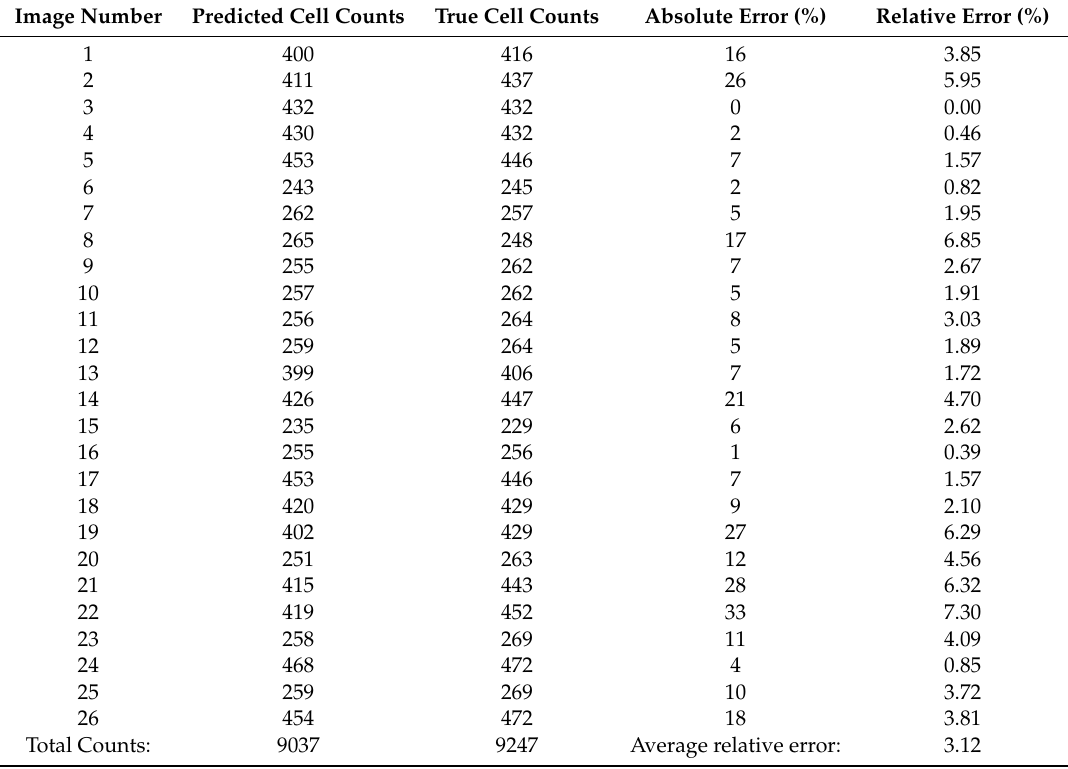
Table 1. Validation Results Obtained on Images Selected from Two Series Never Seen by the